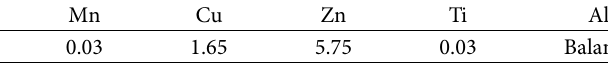
Table 1: Chemical composition of AA7075 alloy (reproduced from Bhowmik et al. [24]). Elements Cr Fe Si Mg Mn Cu Zn